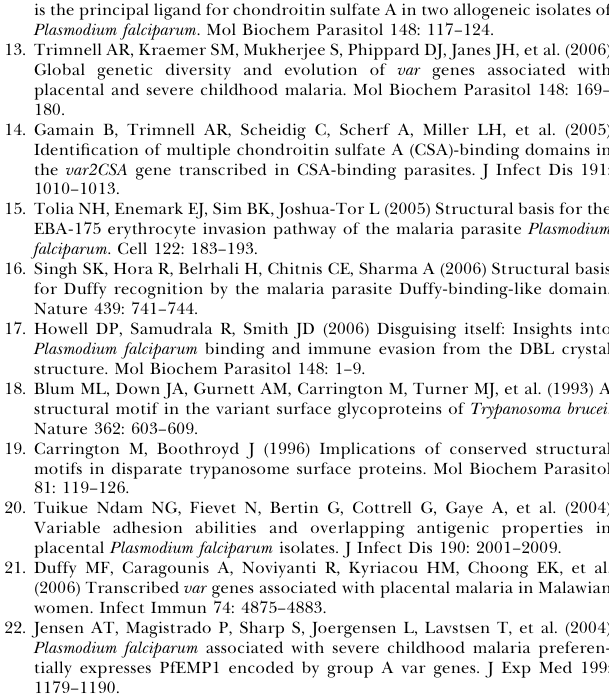
Figure S1. Multiple Structural Alignment of VAR2CSA DBL3X, EBA- 175 F1, EBA-175 F2, and Pk a -DBL Cysteines in conserved disulfide bonds are highlighted in blue, conserved tryptophans buried in the structures are shown in red, and other conserved, buried, and hydrophobic positions are shown in green.